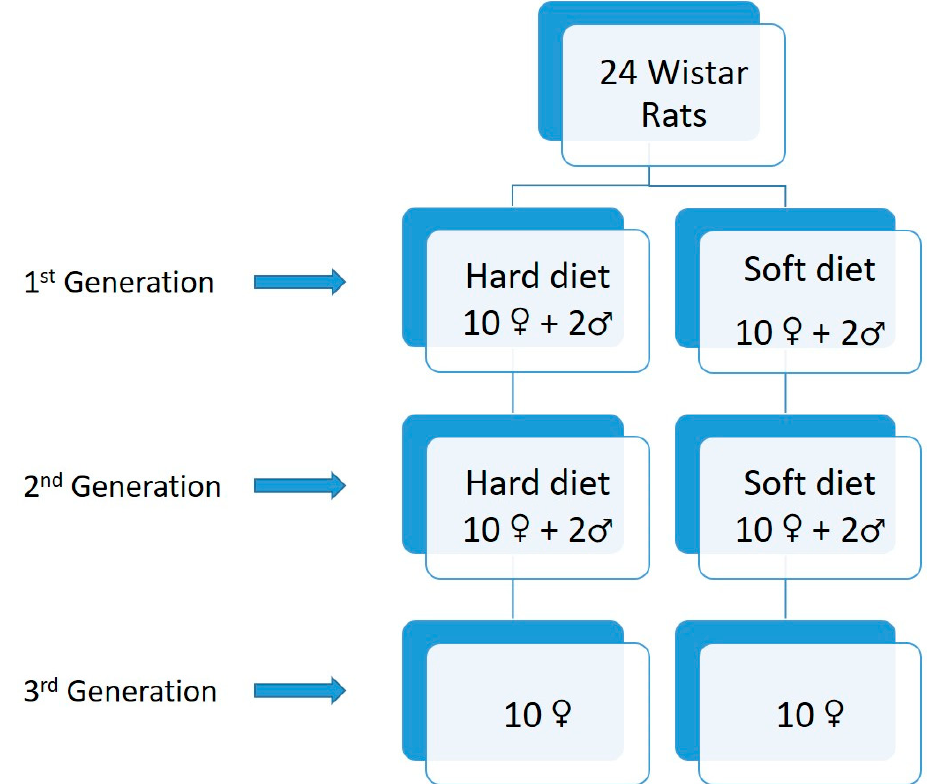
Figure 1. Diagram of the reproduction mechanism. Figure 1.